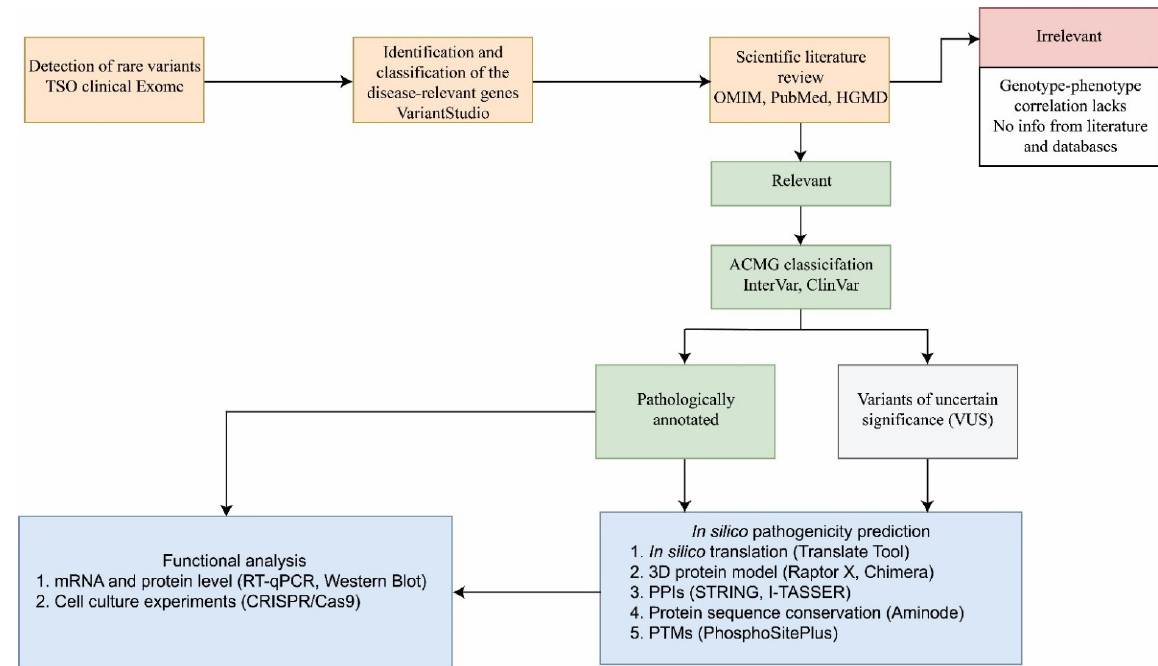
Figure 1. Pipeline designed for identification, classification, and functional analysis of novel genetic variants and candidate genes. The pipeline consists of three main steps. Orange rectangles represent the first step: (1) sequencing, detection, and identification of genes/variants. TruSight One Gene Panel was used for the sequencing of the samples. The Variant Studio software was used for detection and variant filtering. Relevant variants were checked using OMIM, HGMD, and PubMed databases. Irrelevant variants were labeled with the reddish rectangle. The green rectangles represent the second step: (2) classification of variants according to their effect. ACMG classification (within the Varsome database), InterVar software, and ClinVar database were used to classify detected variants according to their consequences. The blue rectangles represent the third step of the pipeline: (3) functional analysis and/or in silico analysis. The variants labeled as pathogenic can be directly functionally characterized but can also be subjected to in silico analysis. For the variants of unknown significance, the in silico pathogenicity prediction precedes the experimental analyses. PPIs—protein-protein interactions; PTMs—posttranslational modifications .